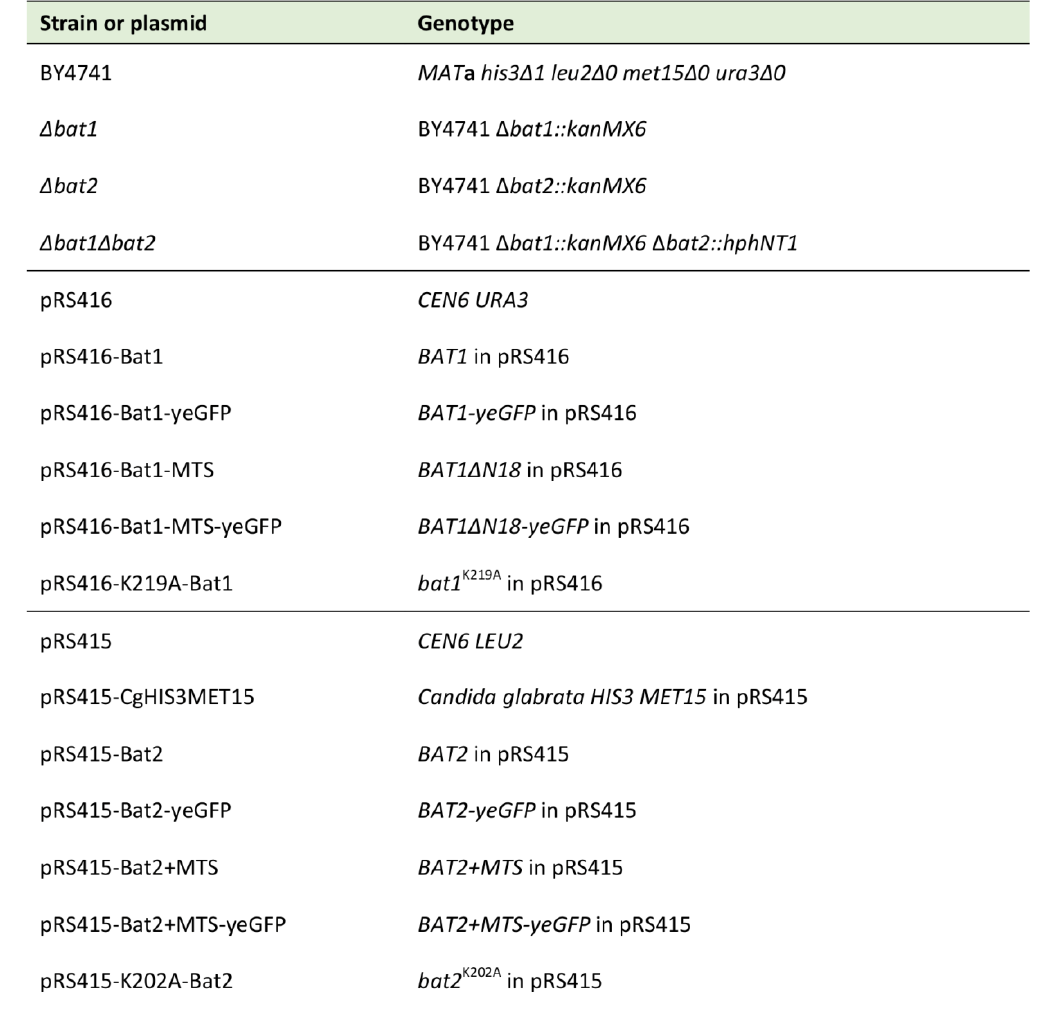
TABLE 1. Yeast strains and plasmids used in this